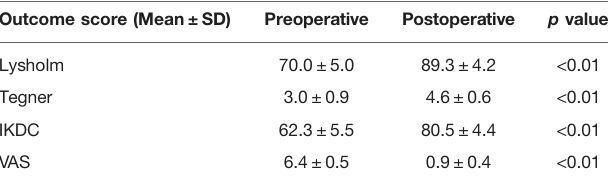
TABLE 2 | Pre- and Post-operative Knee Function Scores for Patients Included. Outcome score